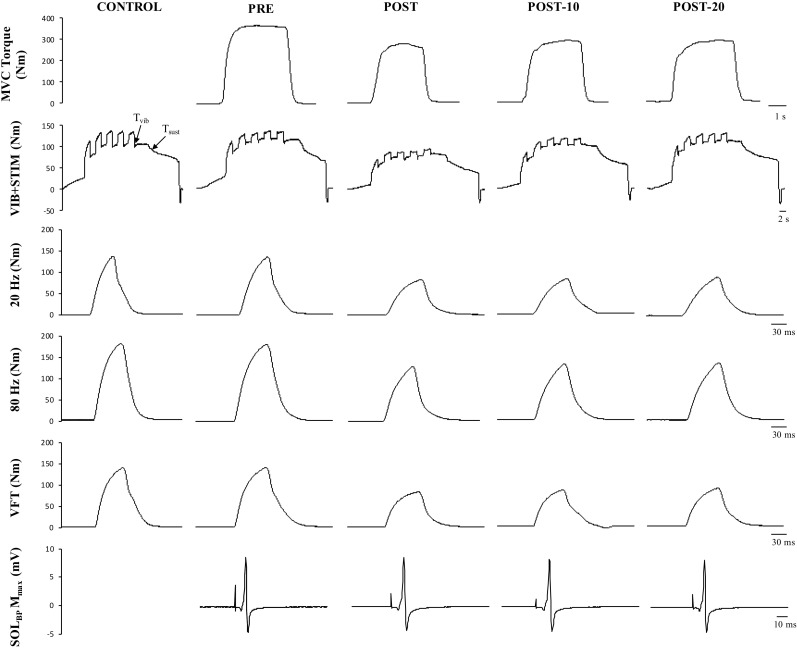
Example data obtained from one participant in the non-caffeine session in Experiment 2 before (PRE) and immediately (POST), 10 min (POST-10) and 20 min (POST-20) after the exercise protocol. Decreases in MVC torque (first row), reflexive torque (second row), and tetanic stimulations are noticeable immediately after the exercise protocol.